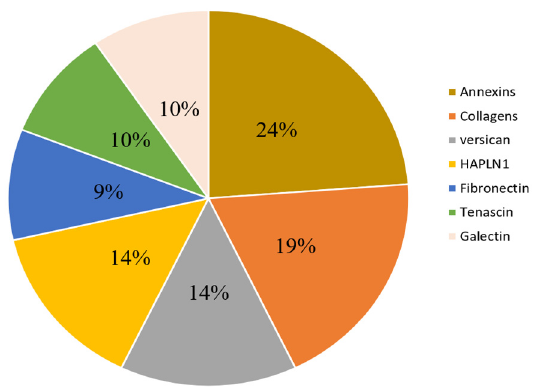
Figure 5. Frequency of commonly reported (reported from, at least, two of the included studies) differ- entially expressed proteins from postmortem tissue of PD patients compared with healthy